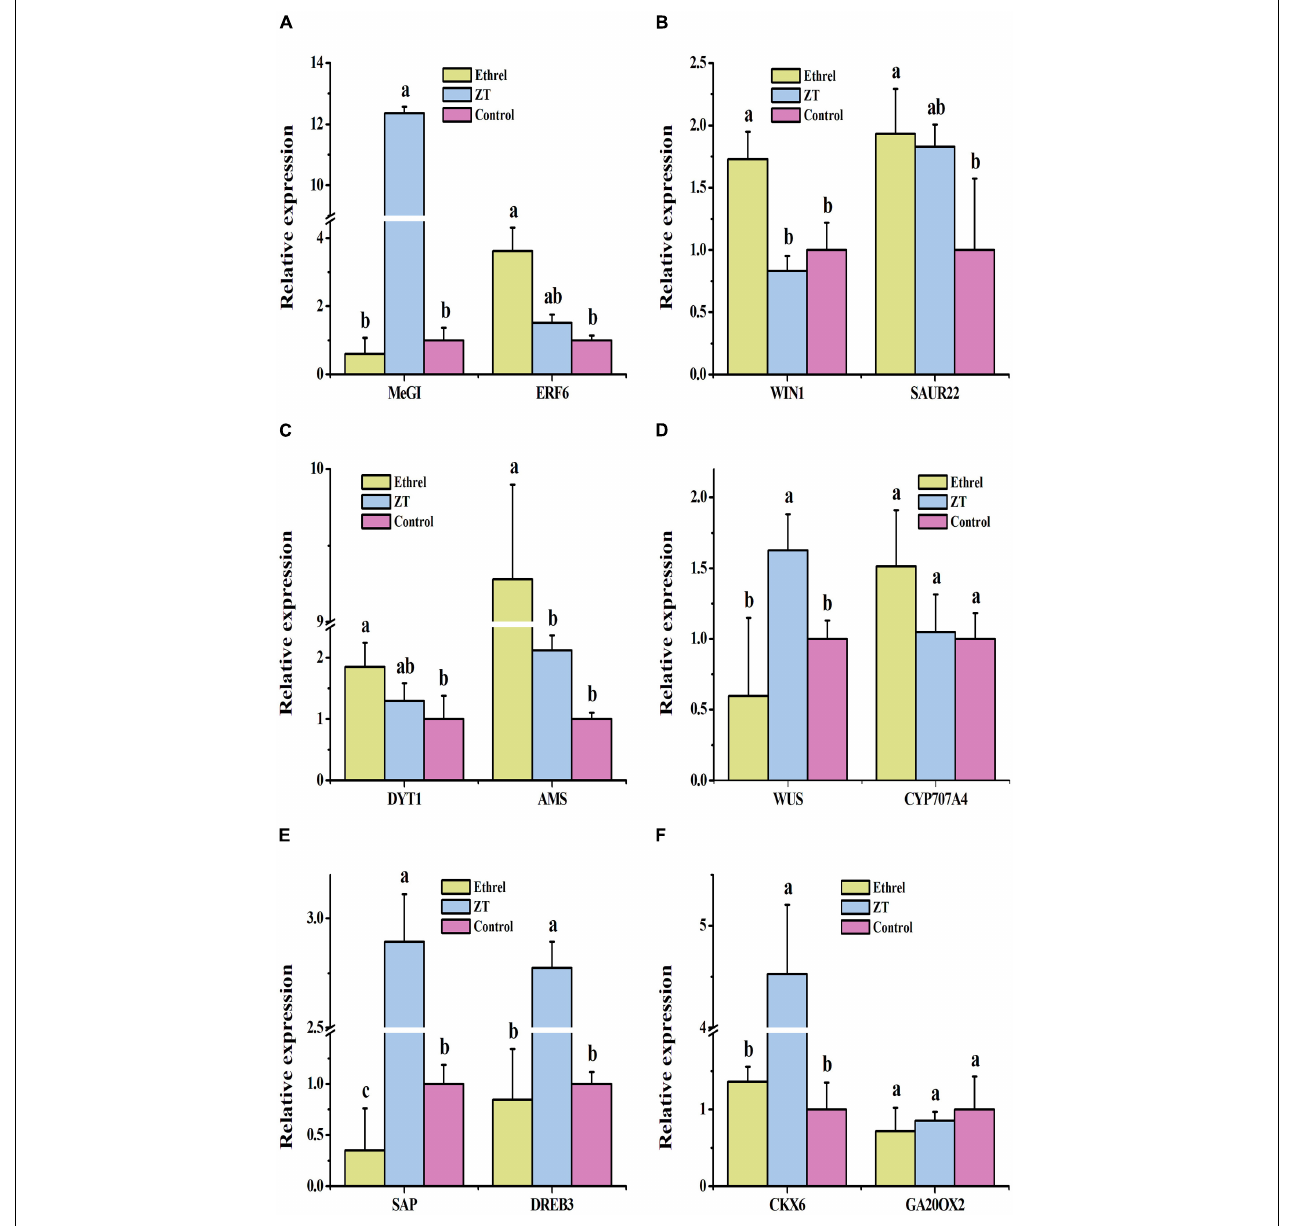
FIGURE 5 | Effects of exogenous ethrel and ZT on the relative expression levels of candidate genes in androecious persimmon flowers. (A) Relative expression levels of MeGI and ERF6 . (B) Relative expression levels of WIN1 and SAUR22 . (C) Relative expression levels of DYT1 and AMS . (D) Relative expression levels of WUS and CYP707A4 . (E) Relative expression levels of SAP and DREB3 . (F) Relative expression levels of CKX6 and GA20OX2 . Different letters denote significant differences among the treated and control groups (Tukey’s test, P <